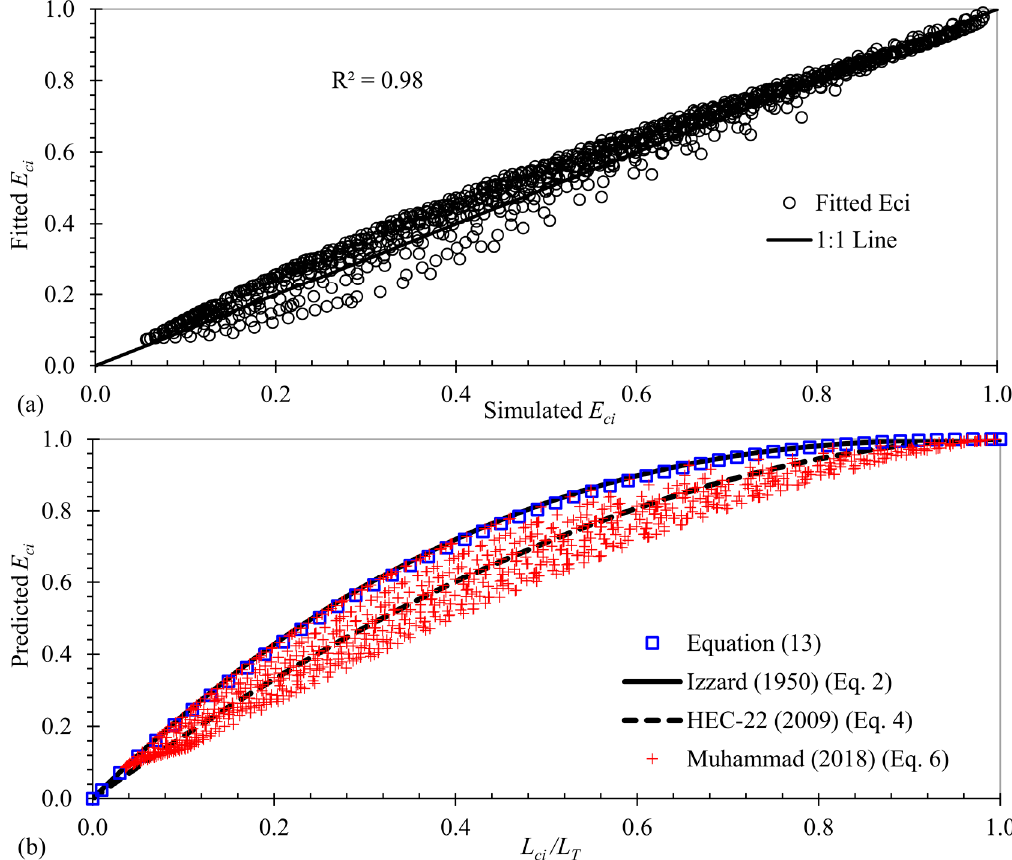
Figure 7. Comparison of fitted or predicted and simulated curb inlet interception efficiency E ci , ( a ) comparison of fitted and simulated E ci , ( b ) relationship between predicted E ci of L ci / L T .